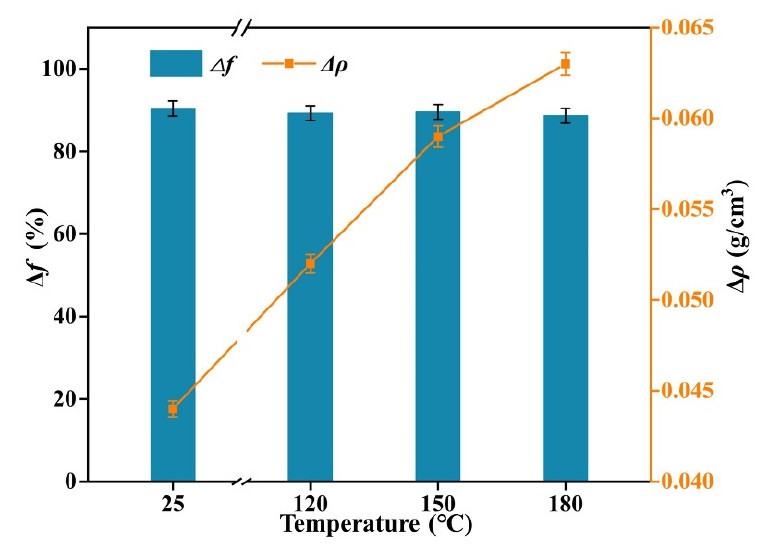
Figure 12. L-541 (cid:48) s high-temperature resistance test Figure 12. L-541 ′ s high-temperature resistance test results.